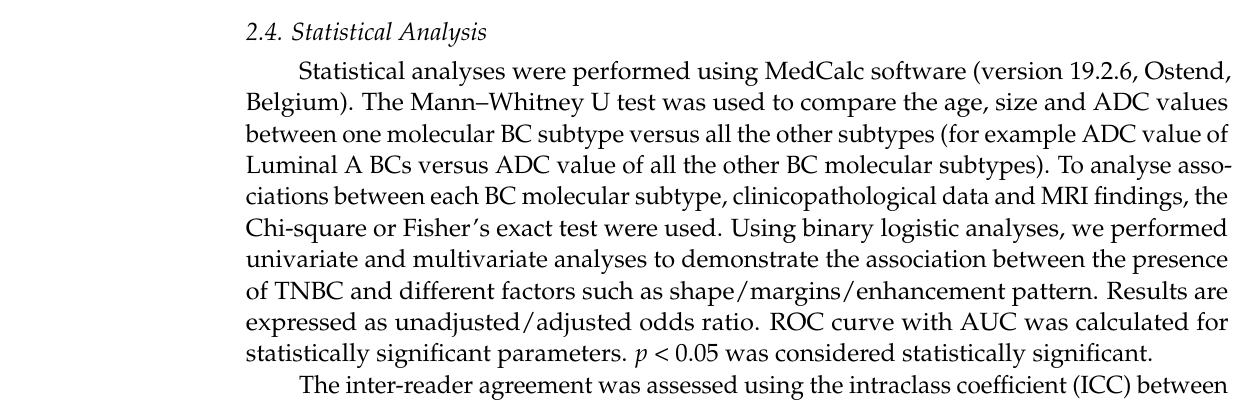
Table 1. Breast cancer molecular subtypes based on immunohistochemistry findings. Luminal A Luminal B Luminal B-like HER2+ Triple Negative (TN) ER+ ER+ ER+ ER − HER2+ PR − PR − HER2 − High Ki-67/PR − Any PR HER2+ HER2 − Low Ki-67 Any Ki-67 ER = estrogen receptor, PR = progesterone receptor, HER2 = human epidermal growth factor 2, Ki-67% = proliferation index with low Ki-67% < 20% and high ki-67% >